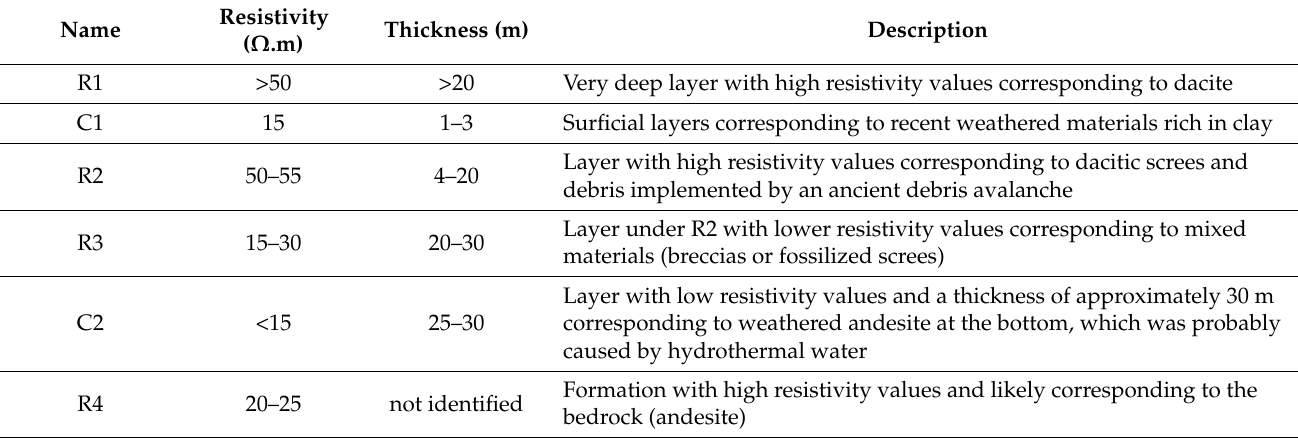
Table 3. Characteristics of the different formations observed in the La M é daille